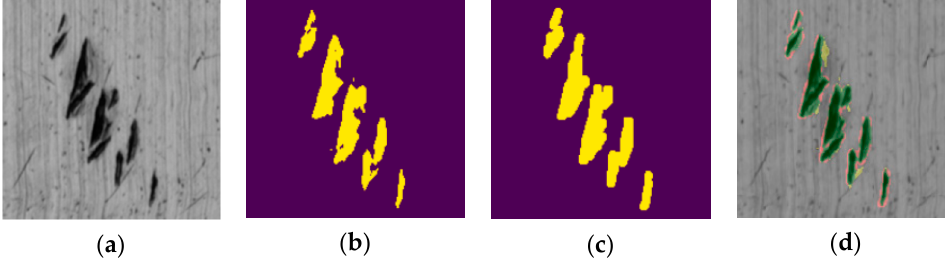
Figure 8. ( a ) An excerpt of a rolling element scan with a defect. ( b ) The binarized network segmentation prediction corresponding to the excerpt in ( a ). ( c ) The manually created label corresponding to the excerpt in ( a ). ( d ) Both binary masks in the left images are overlaid on top of the original input image. The intersection of both masks is highlighted green, while the false positive predictions of the network are highlighted in yellow and the false negatives in red.